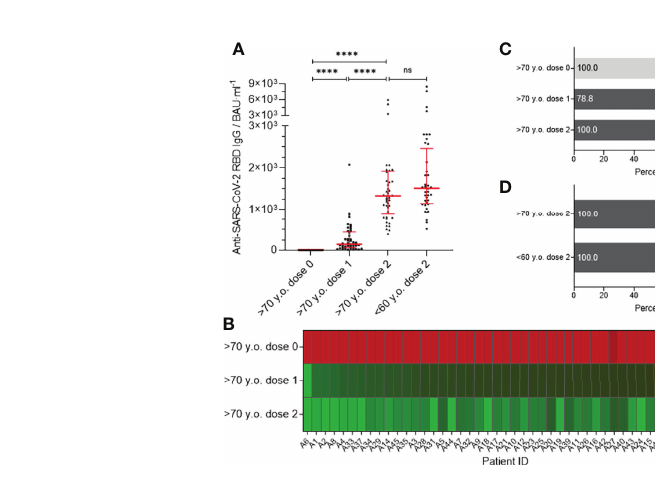
FIGURE 2 | SARS-CoV-2 antibody titer analysis using sera from participants older than 70 years (n = 45) before vaccination (dose 0), after fi rst- (dose 1) and after second vaccination (dose 2) with BNT162b2 in contrast to second dose vaccinated participants younger than 60 years of age (n = 40). Experiments for participants were executed with chemiluminescent immunoassay DiaSorin Trimeric S ® IgG against SARS-CoV-2-S. Results are presented in binding antibody units per ml of serum (BAU·ml − 1 ). (A) IgG antibody titers against SARS-CoV-2 S domain are shown as individual progression for each person until full immunization with BNT162b2. In contrast, individual anti-SARS-CoV-2 IgG titers are illustrated for people younger than 60 years fully vaccinated with BNT162b2. Medians are visualized together with the interquartile range as an error bar. Statistical signi fi cance between values of the three different time points for the group >70 y.o. was determined using the Wilcoxon test. A Mann – Whitney – U test for nonparametric distribution was applied for comparison of immune responses between the two age groups. [p > 0.05 not signi fi cant (ns), and p ≤ 0.0001 (****)]. (B) Heat map for visualization of individual IgG antibody titer progression against SARS-CoV-2 S domain before and after vaccination with BNT162b2. Illustrated colors shift from red for a negative to green for a positive antibody status. (C) Percentages of participants positive, borderline or negative for IgG antibodies against SARS-CoV-2 S1 are shown for time points before-, after the fi rst and second vaccination. (D) Comparison of percentages of persons older than 70 years and people younger than 60 years positive, borderline or negative for IgG antibodies against SARS-CoV-2